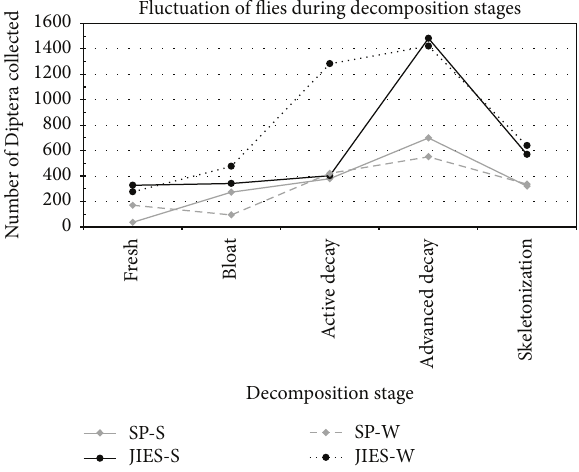
Figure3:Graphicalcomparisonofdipteranfluctuations.SP-S:sum- mer experiment, S˜ao Paulo. SP-W: winter experiment, S˜ao Paulo. JIES-S: summer experiment, Peru´ıbe. JIES-W: winter experiment, Peru ´